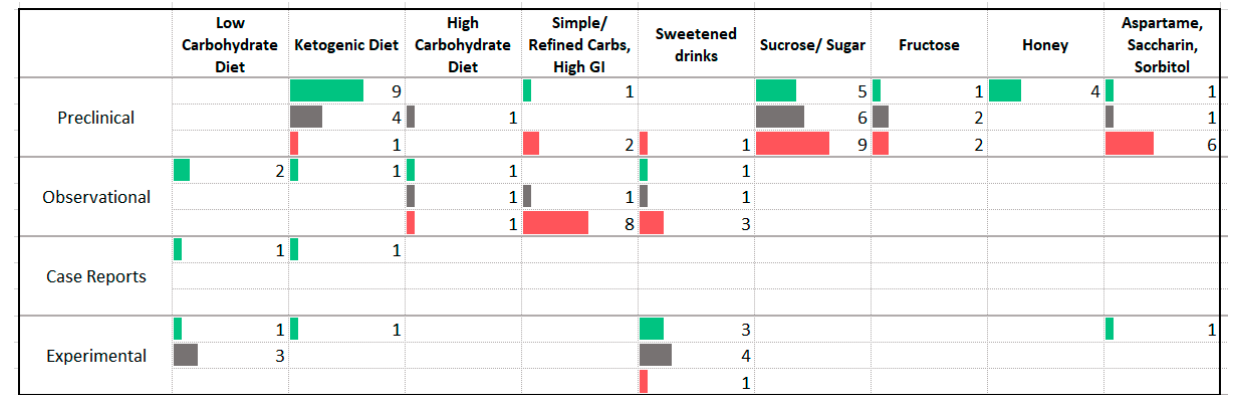
Figure 7. Studies assessing dietary carbohydrates and anxiety. █ Higher intake or levels associated with decreased anxiety. █ No association between intake or levels and anxiety. █ Higher intake or levels associated with increased anxiety.